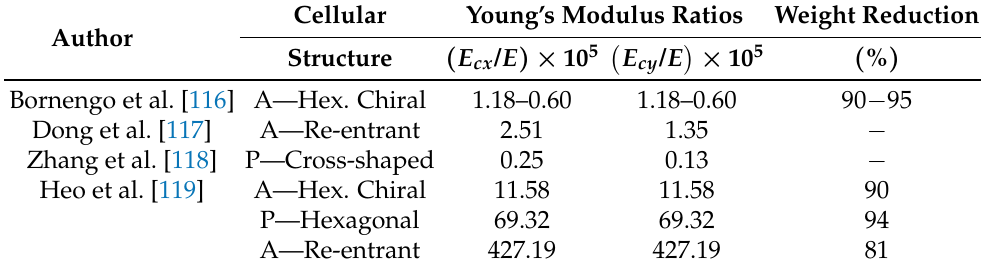
Table 1. Stiffness reduction via Cellular Materials: Airfoil-core morphing. Principal works found in literature by author and cellular structure used (P: positive Poisson, Z: zero-Poisson, A: auxetic). Young’s modulus ratios E c / E between the obtained by the application of Cellular Material, E c , and that of the parent material E for in-plane E cx / E and E cy / E stiffness, and percentage of weight reduction. “ − ” indicates that there is no sufficient information reported to obtain that parame- ter. The percentage of weight reduction was obtained based on the reported relative density ¯ ρ of the cellular